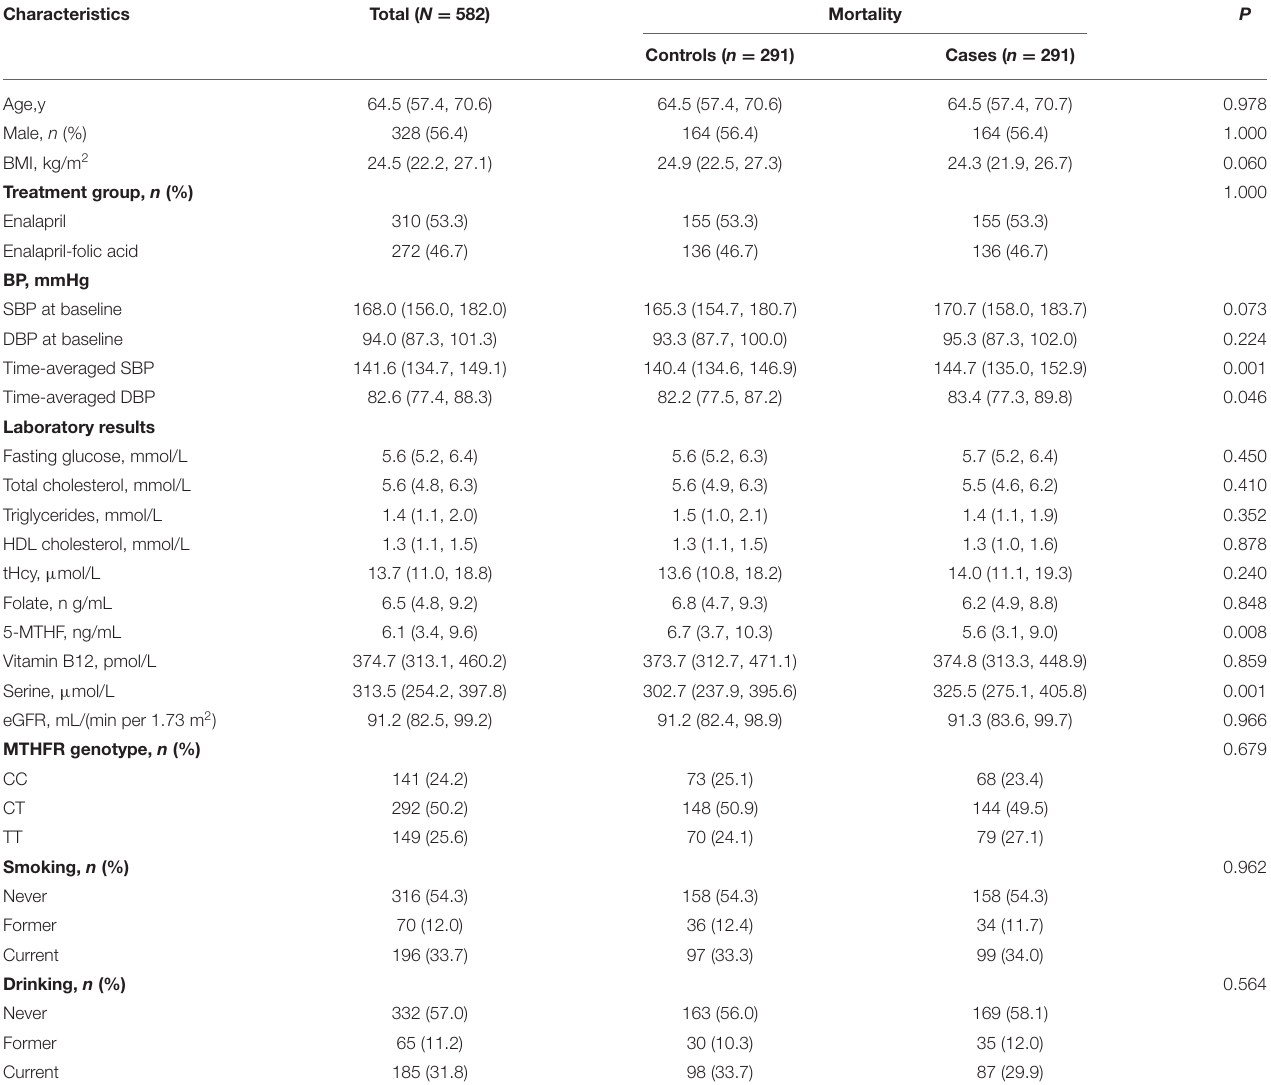
TABLE 1 | Baseline characteristics of the study participants stratified by control and case.